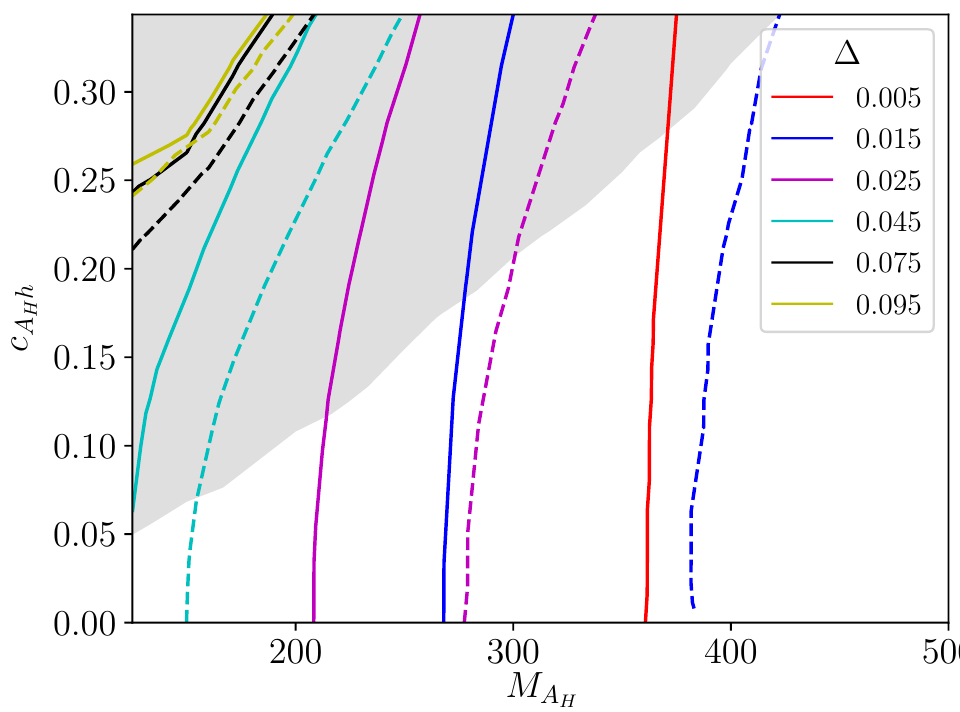
Figure 18 . Contours of Ω h 2 = 0 . 12 for fixed values of ∆ . The region to the right of the curve gives too large DM density and is excluded. The solid (dashed) curves correspond to q H = 0 . 1 ( q H = 0 . 2 ). The shaded region is excluded from direct detection experiments. See text for